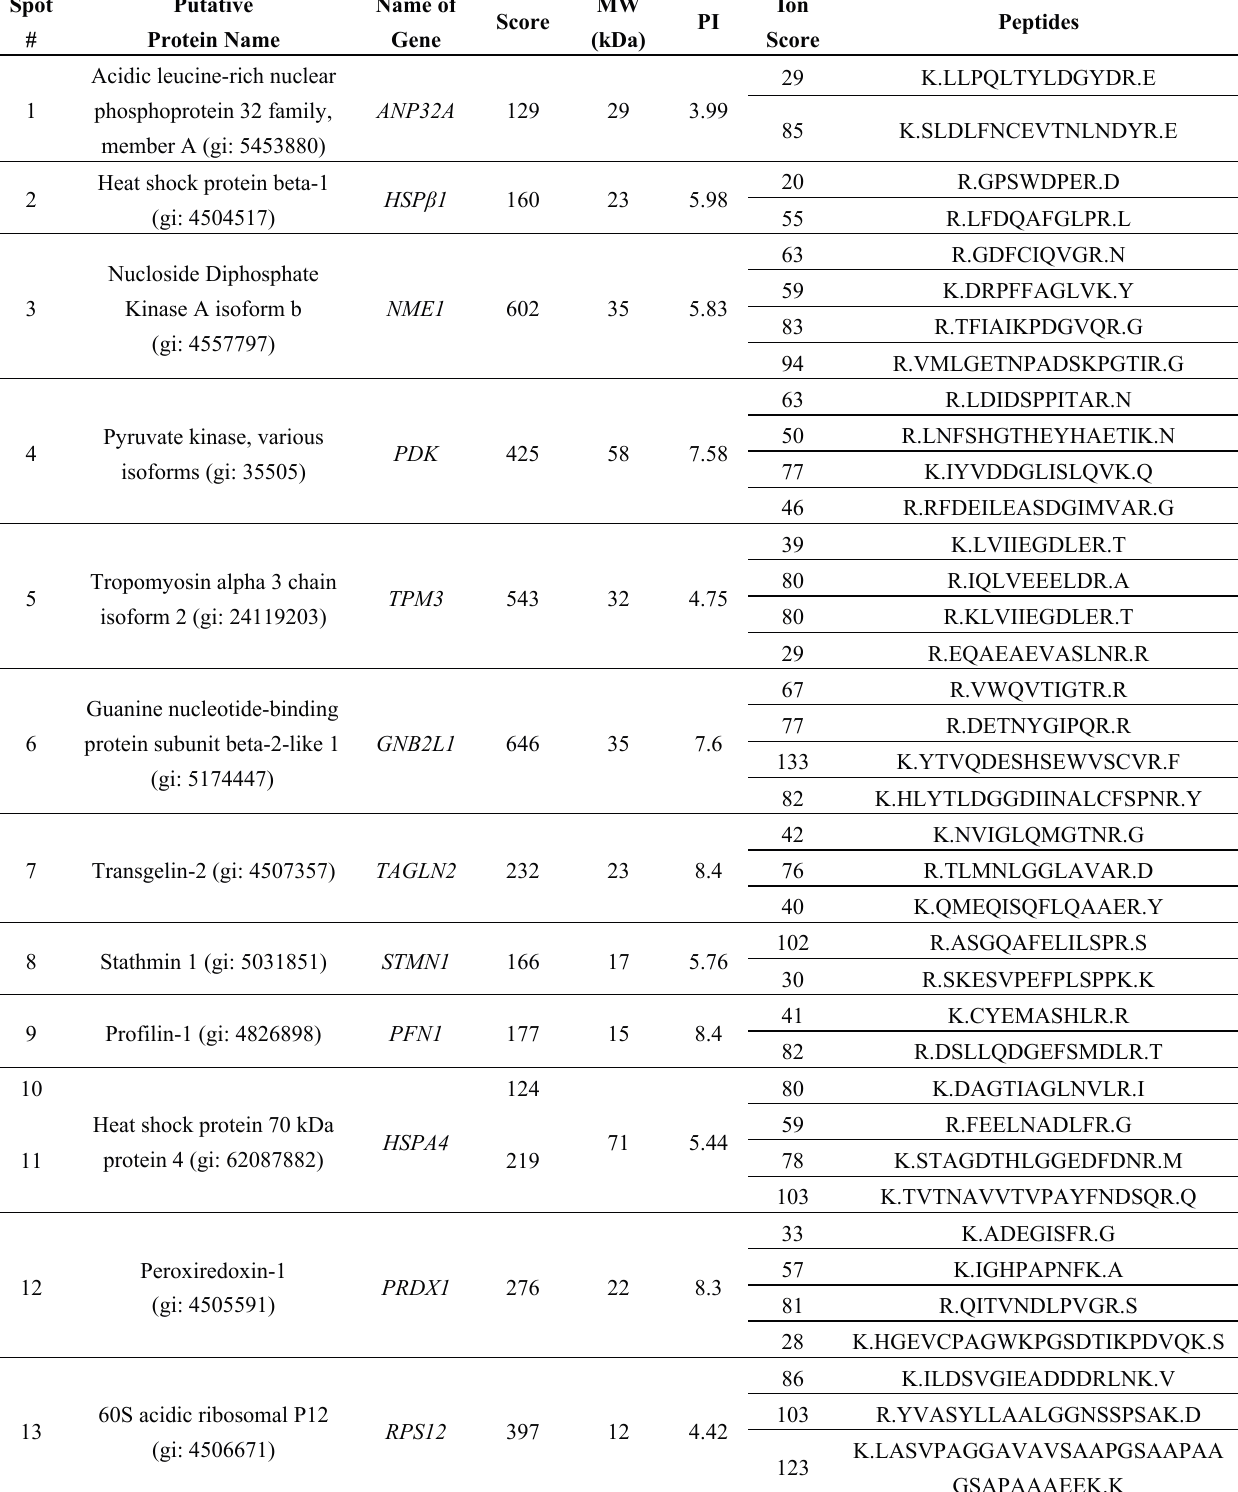
Spot #: Protein spots were numbered exactly as those presented in Figure 1. Score: Mascot MS protein score obtained by analysis based on PMF (peptide mass fingerprint). Score greater than 66 indicates identity or extensive homology. MW: Predicted molecular weight (MW) in dalton (Da) according to protein sequence. PI: Predicted isoelectric point (PI) of the protein according to sequence. Ion Score: Mascot MS/MS ion score obtained by analysis based on MS/MS spectrum. Ion scores greater than 26 and 43 indicate homology and identity